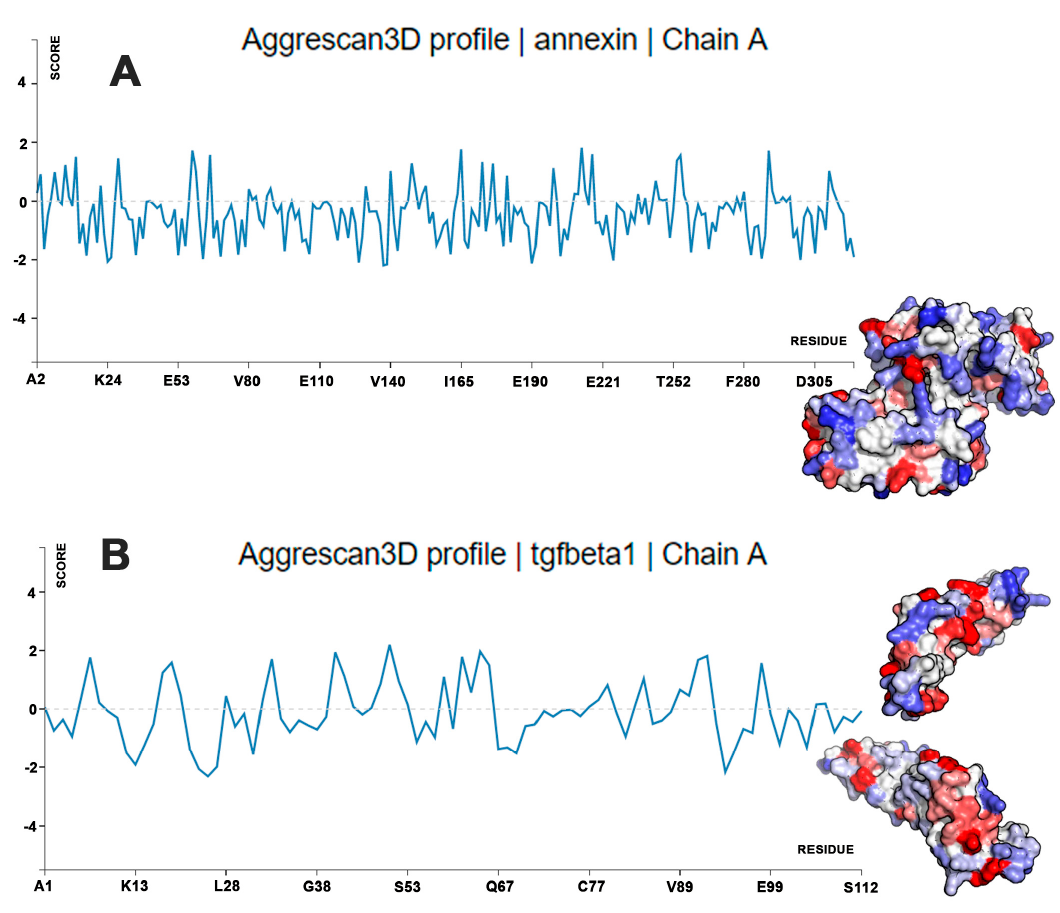
Figure 3. Aggrescan3D calculations: aggregation propensity and water solubility of Annexin V ( A ) and TGF- β 1 ( B ). The Aggrescan3D profile shows the score for each residue at the protein surface; the more negative the score, the lower the contribution of the residue to protein aggregation. Color code: red residues are predicted to have the highest aggregation propensity and lowest water solubility, while white and blue residues are predicted to have the lowest aggregation propensity and highest water solubility.